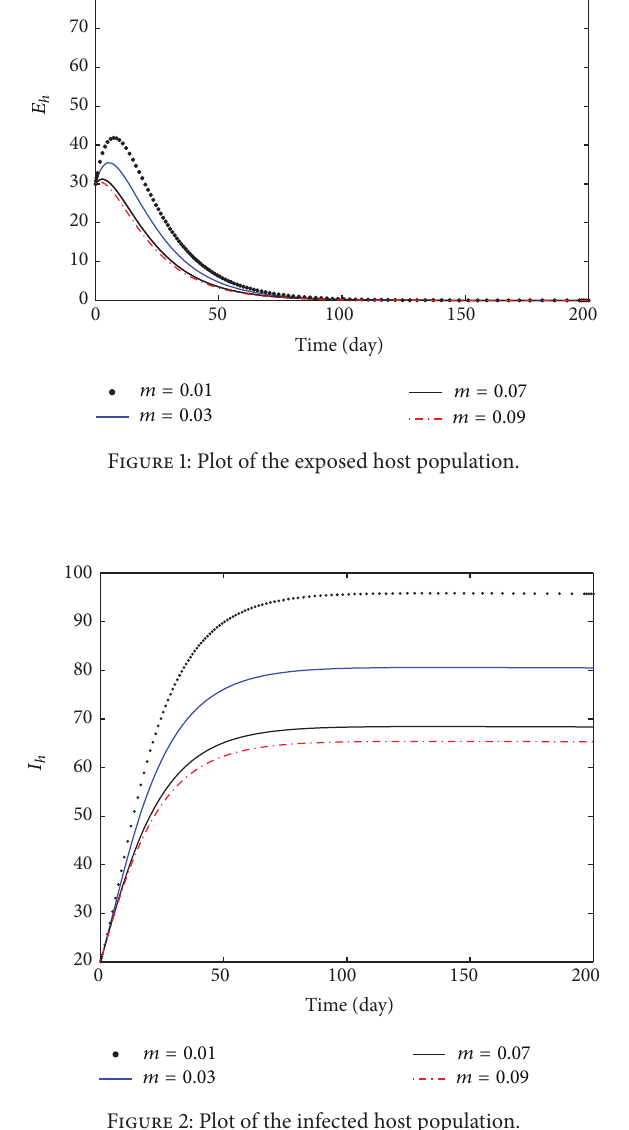
Figure 2: Plot of the infected host population.